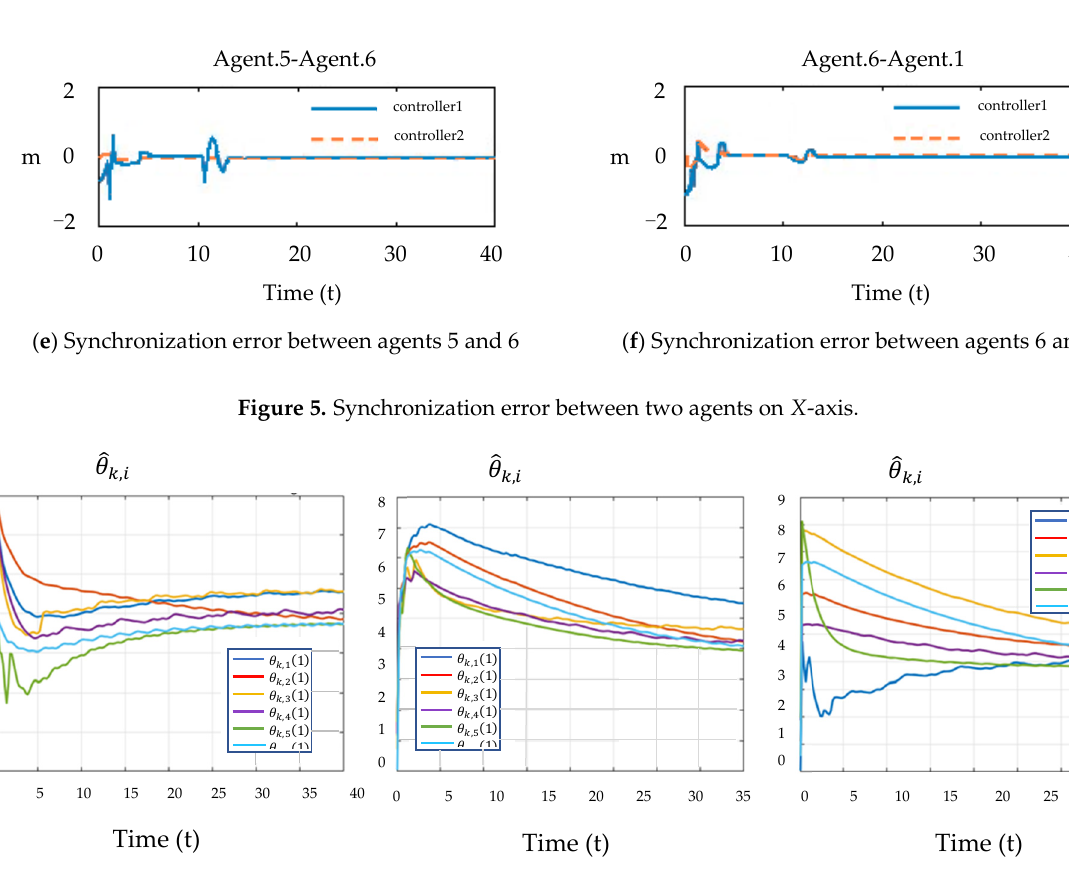
Figure 6. Kinematic parameter estimates (cid:2016)(cid:3552) (cid:3038),(cid:3036) when (cid:2016)(cid:3552) (cid:3038),(cid:3036) (0) has three different initial values. ( a ) ˆ θ k , i ( 0 ) = ˆ θ k , i ( 01 ) , ( b ) ˆ θ k , i ( 0 ) = ˆ θ k , i ( 02 ) , ( c ) ˆ θ k , i ( 0 ) = ˆ θ k , i ( 03 )